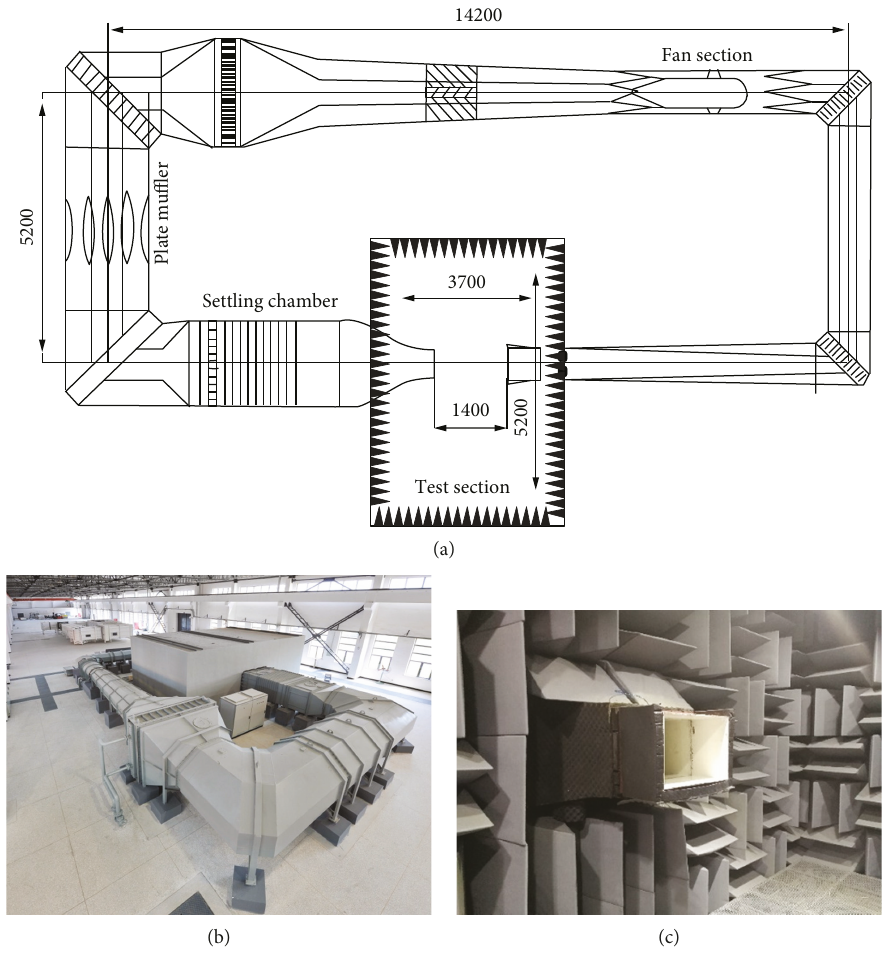
Figure 2: 0 55m × 0 4 m aeroacoustic wind tunnel in CARDC: (a) plan; (b) full view; (c) anechoic chamber with the main fl ow nozzle outlet.